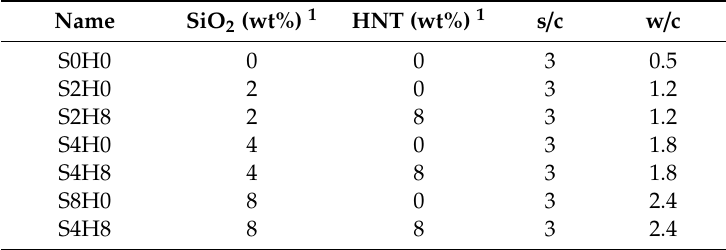
Table 1. Composition of the cementitious